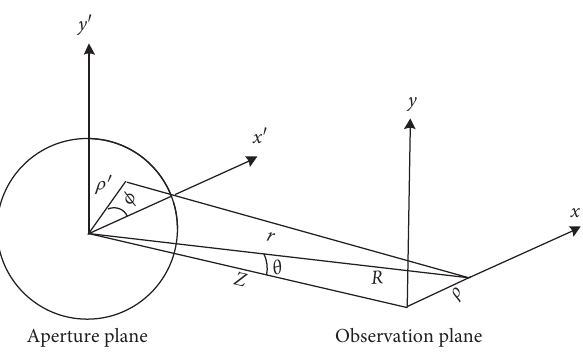
Figure 1: Geometry of diffraction by a circular